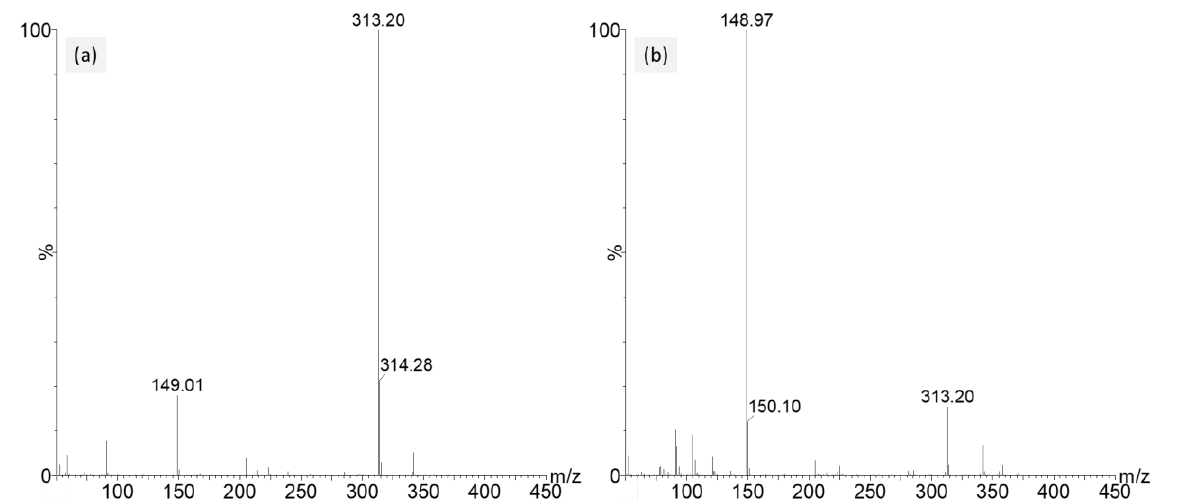
Figure 1. Mass spectra of BBP in full scan mode under wet ( a ) and dry ( b ) conditions.